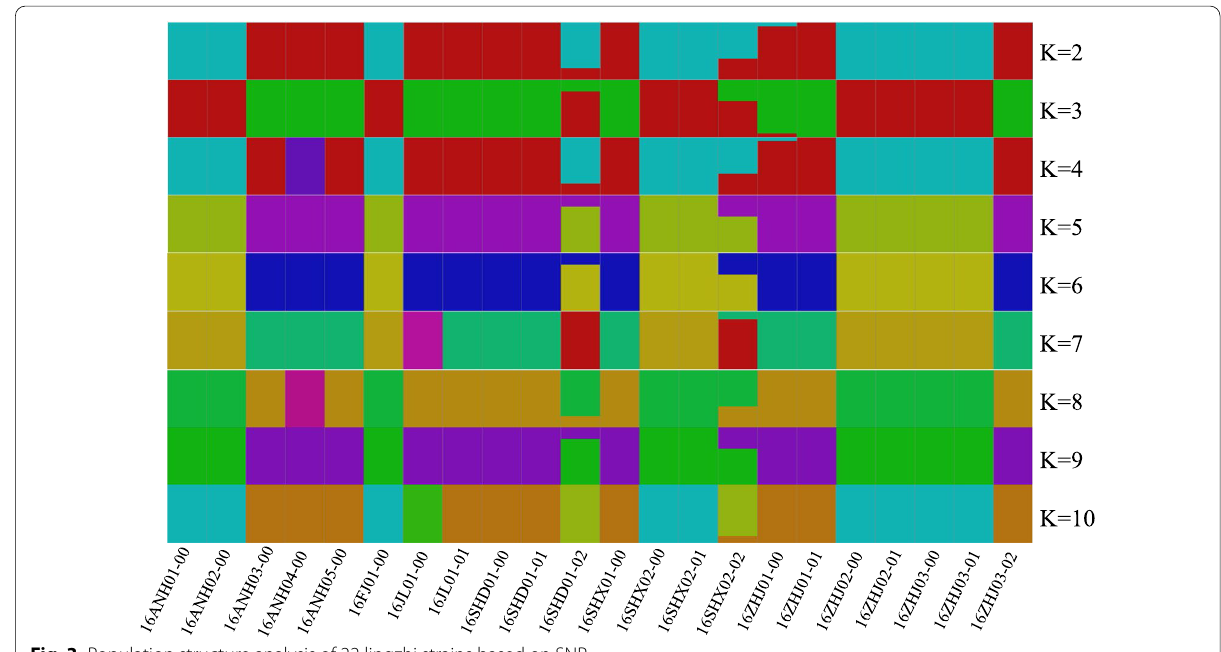
Fig. 3 Population structure analysis of 22 lingzhi strains based on